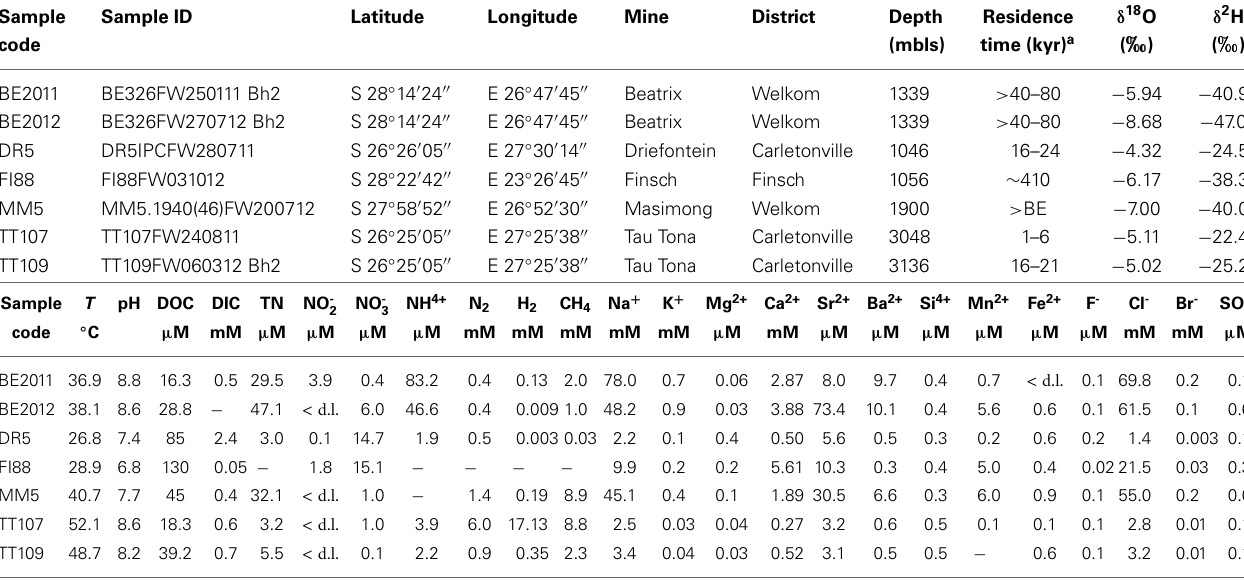
Table 1 | Geographical, physical, and chemical characteristics of the